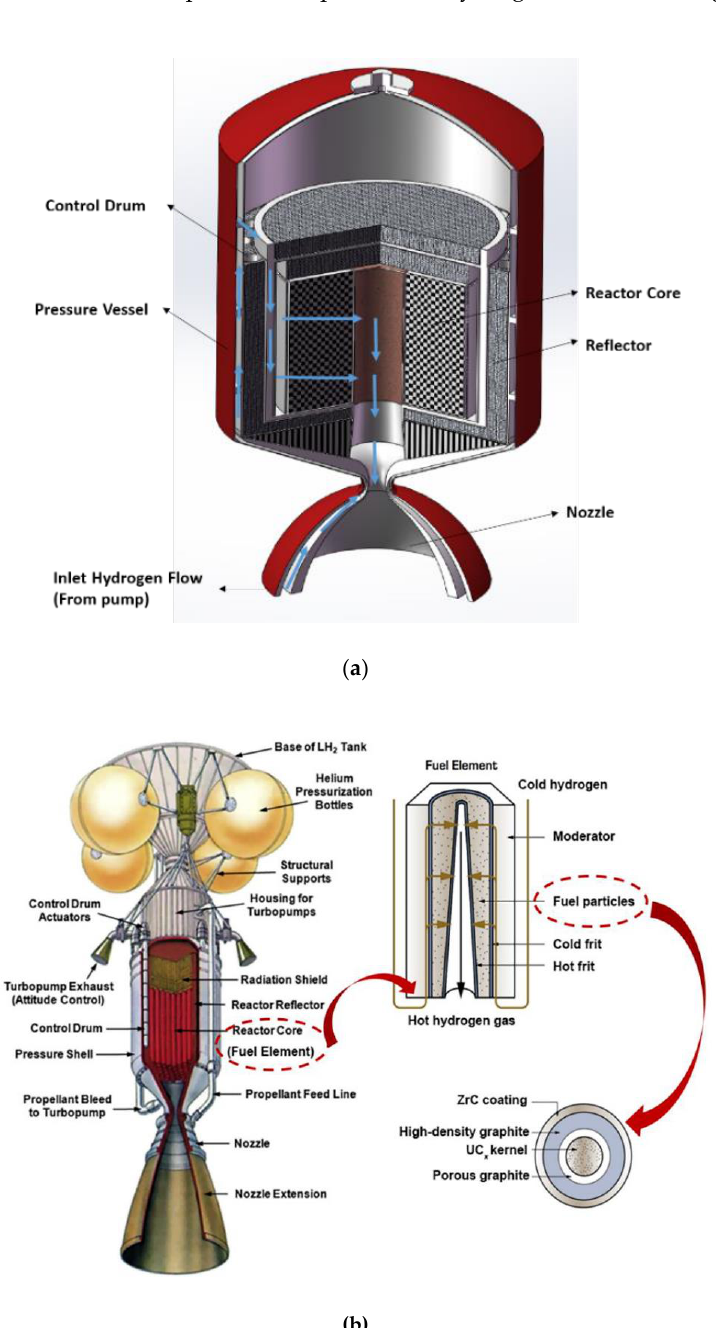
Figure 2. Schematic view of a particle bed reactor (PBR) for propulsion. ( a ) Individual PBR core; ( b ) fuel elements-assembled PBR core